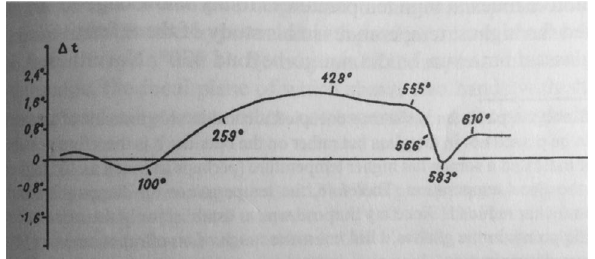
Figure 1. The experimental result of the temperature difference ∆t between the borosilicate crown glass and the neutral glass sample. The characteristic curve inflection between 555 and 610 °C shows a heat absorption process in the borosilicate crown glass. Reproduced from Ref. 1